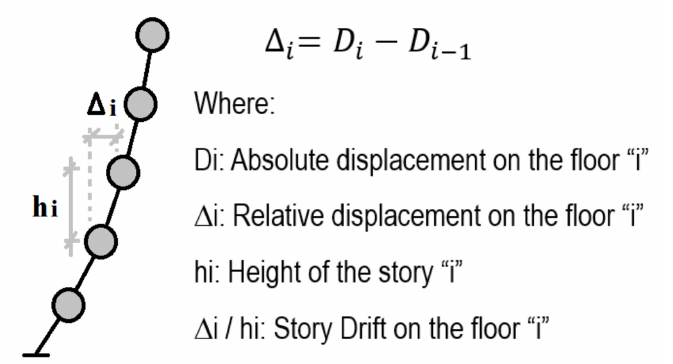
Figure 4. Definition of story drift ratio.